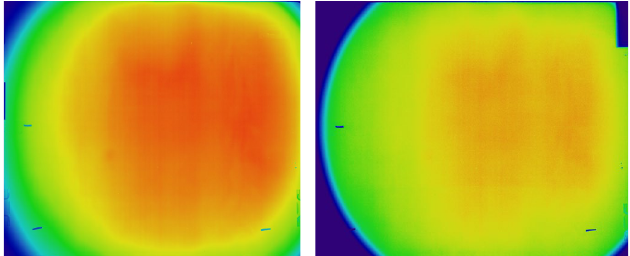
Fig. 6. The resulting image of the beam profile for the OB (left) and CB (right) configurations (a filter is used for visual